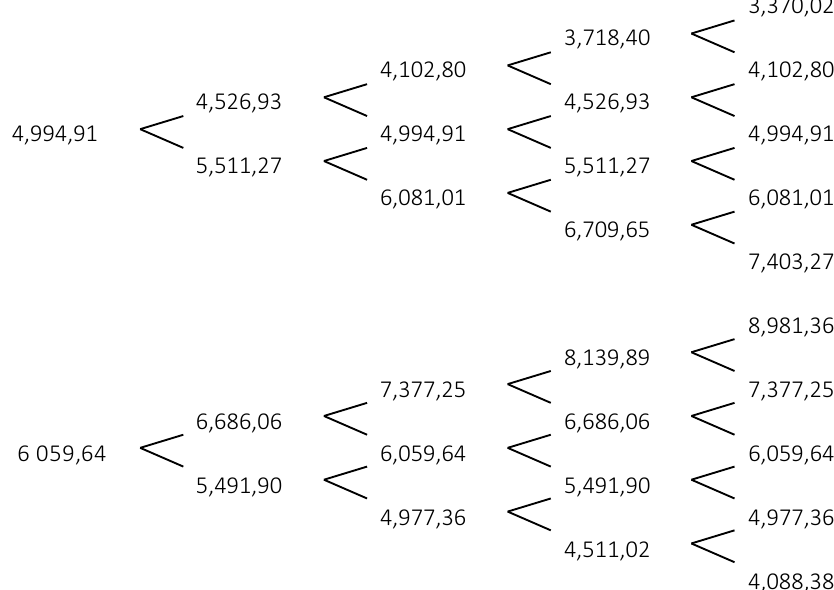
Figure 1. Formation of benefits obtained from having shopping centre SC (top) and office space OS